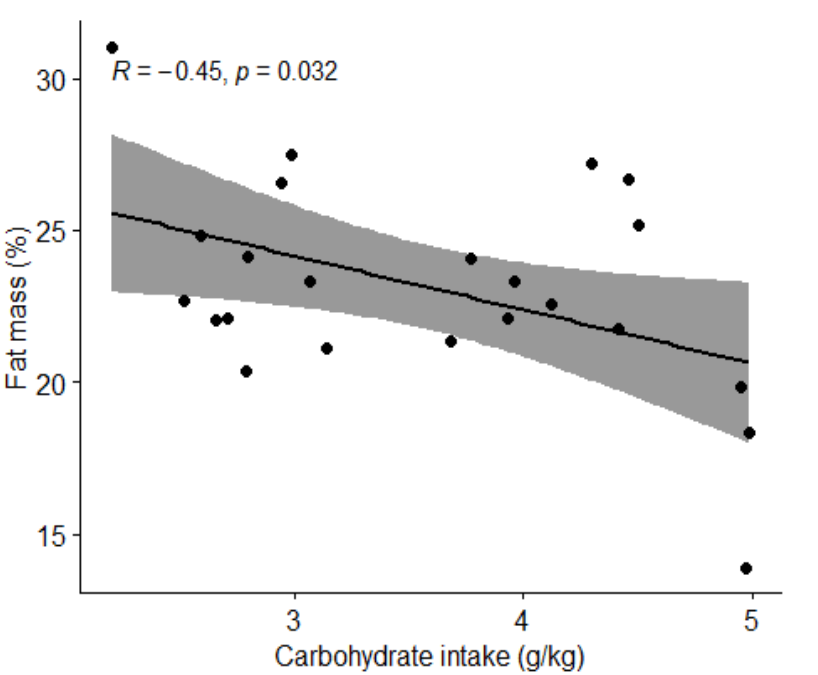
Figure 8. Correlation between carbohydrate intake and body fat percentage in football players. Dots represent individual participants ( n = 23). Grey shaded area indicates 95% CI.